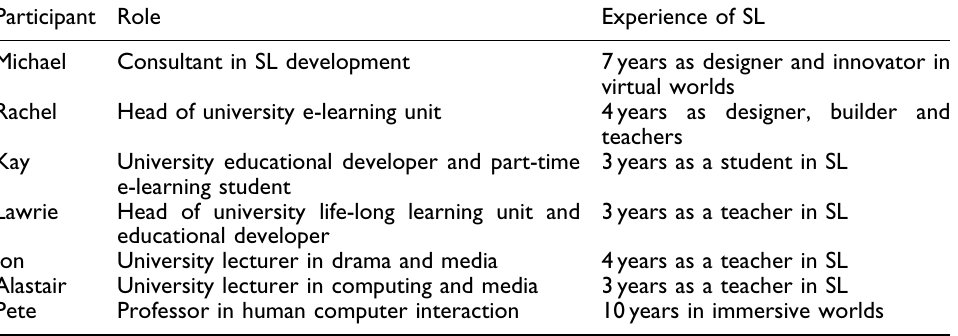
Table 1. Overview of